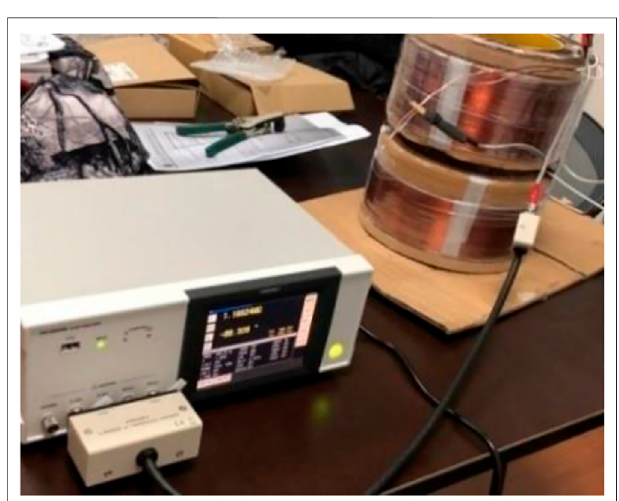
FIGURE 12 | Winding AC equivalent resistance